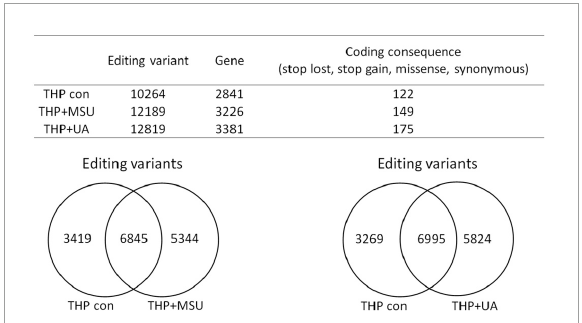
FIGURE5 Genome-wide analysis of RNA editing in MSU- or UA-treated THP-1 cells. The upper panel shows the numbers of variants and genes with RNA editing in mock, MSU-treated, or US-treated THP-1 cells. The numbers of variants in the coding sequence were further analyzed. RNA editing affected the coding sequence, including gain of stop codon, loss of stop codon, missense mutations, and non-synonymous mutations. The left lower panel displays the common variants and unique variants in untreated and MSU-treated THP-1 cells, and the right lower panel presents the common variants and unique variants in untreated and UA-treated THP-1 cells.